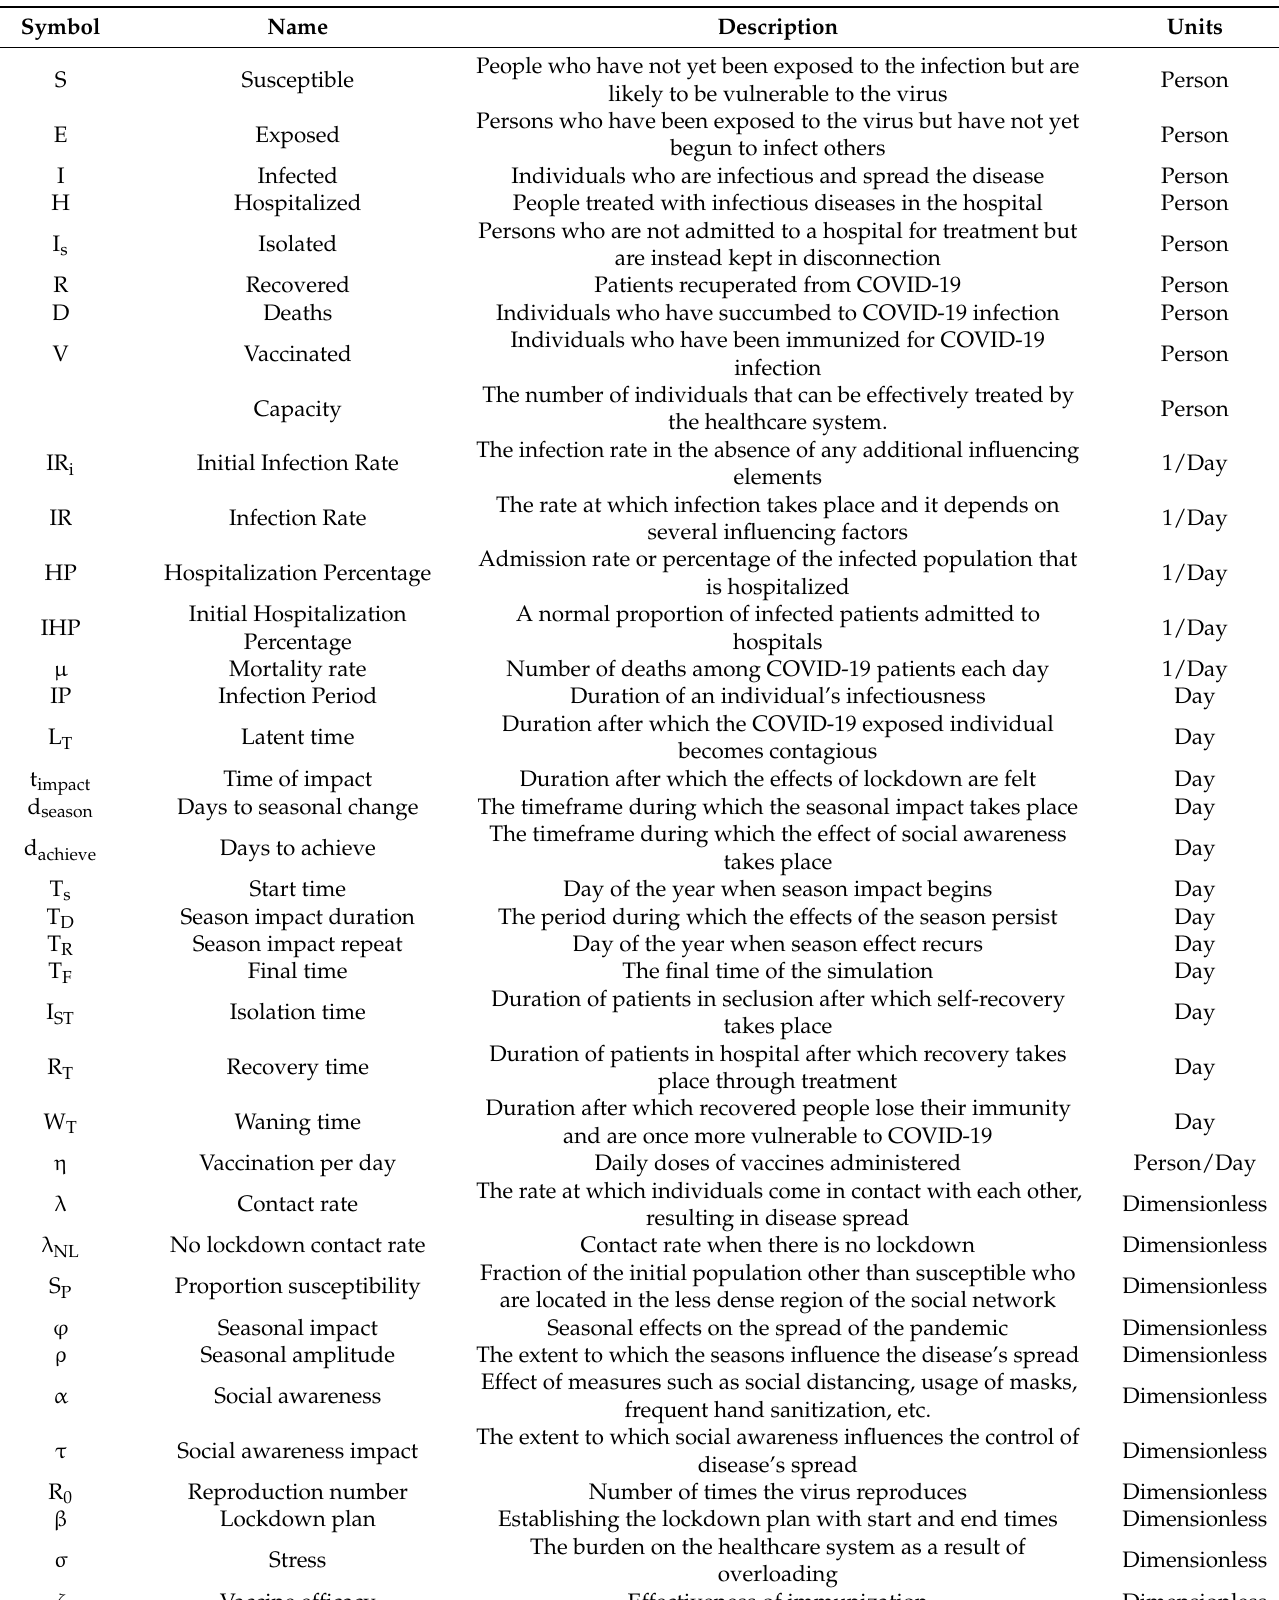
Table 1. Notations deployed in the SEIHI s RS